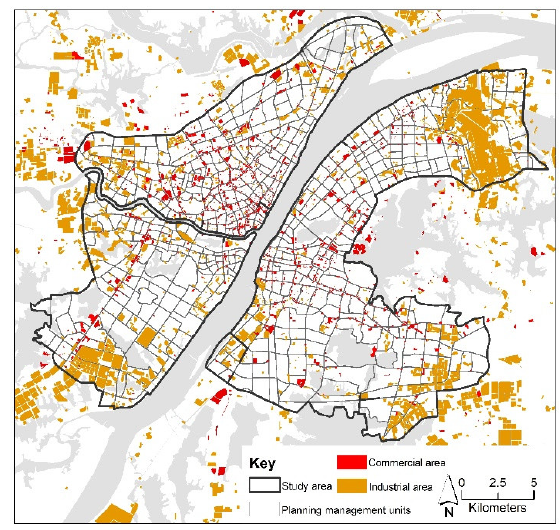
Figure 4. Spatial layout of industrial and commercial areas.